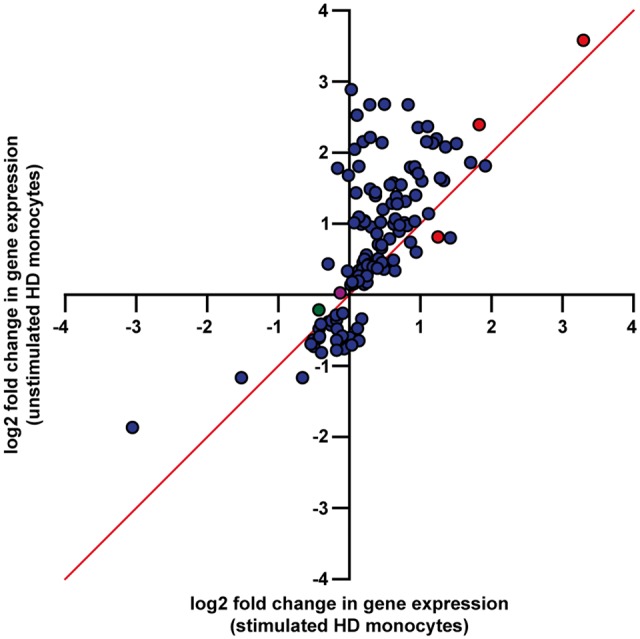
Comparison of log2 fold changes in resting and stimulated HD and control monocytes. The log2 fold changes for the 130 differentially expressed genes in resting HD monocytes (FDR < 0.05) were compared between the unstimulated and stimulated datasets. The magnitude of the relative expression difference was greater in the unstimulated samples for 116 of these genes, suggesting that transcriptional differences between HD and control monocytes become less pronounced in response to stimulation. Genes which were only differentially expressed in the unstimulated samples are shown in blue, while the three genes which were differentially expressed in both datasets are shown in red. HTT is further shown in green, while the NFĸB transcription factor RELA (p65) is shown in purple (however neither of these genes were differentially expressed). The line x = y is also shown.